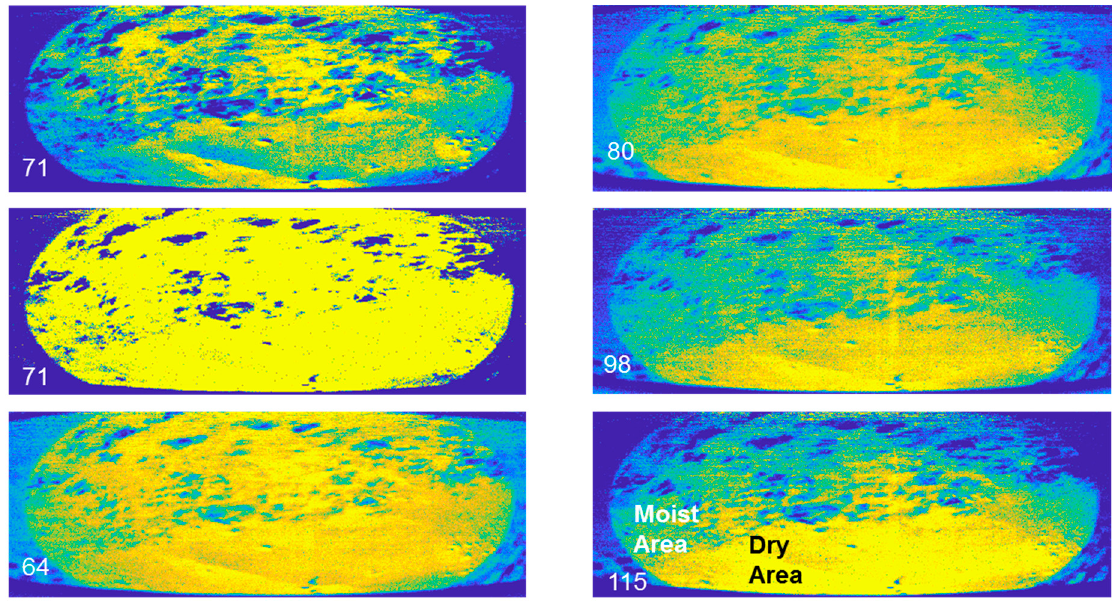
17 of 33 Figure 13. Spectra for a portion of the radiance image (for channel 112, near 5.068 μ m) near a cloud feature used for cloud-motion-vector observation. The radiance contrast in the image ( left ) has been expanded and shifted to show the higher brightness temperature of the water vapor field which surrounds the cloud. The brightest regions in the image are those without cloud and with low water vapor concentration. The spectra shown ( right ) are 10×10 pixel averages in the cloud, moist air, and dry air regions (surface emission-dominated) areas in the image. Figure 13 also shows spectra for areas both in and near this cloud. The image in this figure is a small portion of a single spectral channel image for a spectral channel near 5 μ m, lying near one local minimum in spectral radiance, indicating somewhat stronger water vapor absorption and re- emission at a lower temperature for some areas surrounding the cloud. On physical grounds, a water vapor field surrounding this low-level cloud is expected. There is also evidence of a lower-level water vapor field in the radiosonde data, shown in the lower right quadrant of Figure 12. The vertical position of this water vapor field is consistent with being trapped by the same temperature inversion that trapped the clouds observed in Figure 12. Images of the same scene, but for spectral channels near 4.894, 4.952, 5.017, and 5.079 μ m, are shown in Figure 14. The infrared brightness for these channels is progressively lower, indicating that these channels are weighted higher in the atmosphere. The images show a broad region of higher water vapor concentration extending over much of the image, in addition to the moisture field around the lower-level clouds. Figure 15 shows infrared radiance spectra in the MISTiC water vapor band for regions both inside and outside of this moisture field, showing lower infrared radiances,